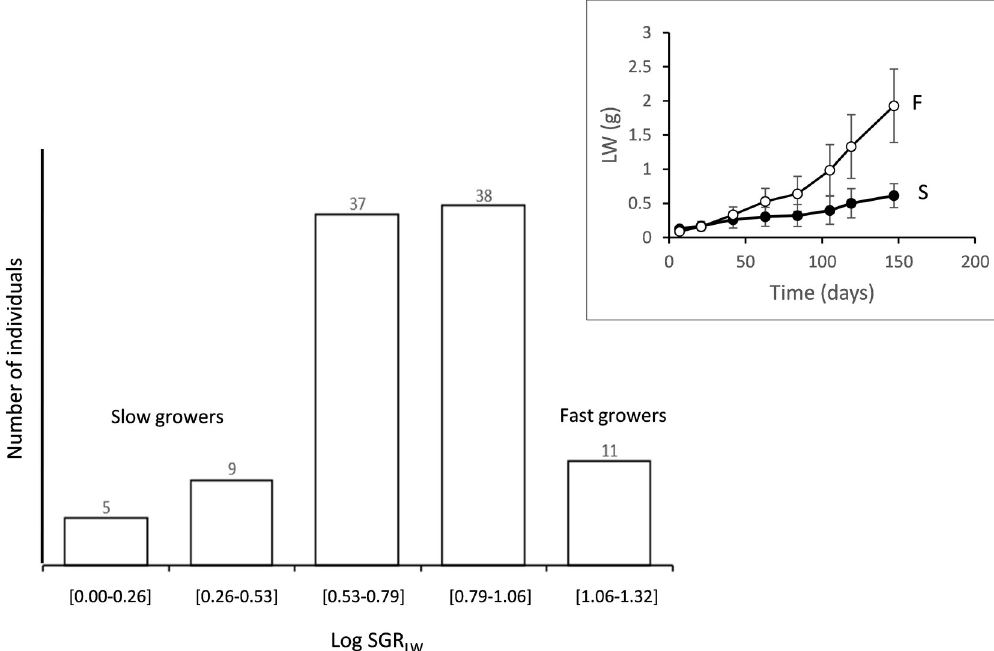
Fig 3. Frequency distribution vs growth intervals. For normality, SGR values were logarithmically transformed. Two groups of slow (S) and fast (F) growers were created with the extremes of the distribution. Insert: Growth trends of segregated groups of fast (F) and slow (S) growing mussels. Data are mean live weight (LW) values ± SE.